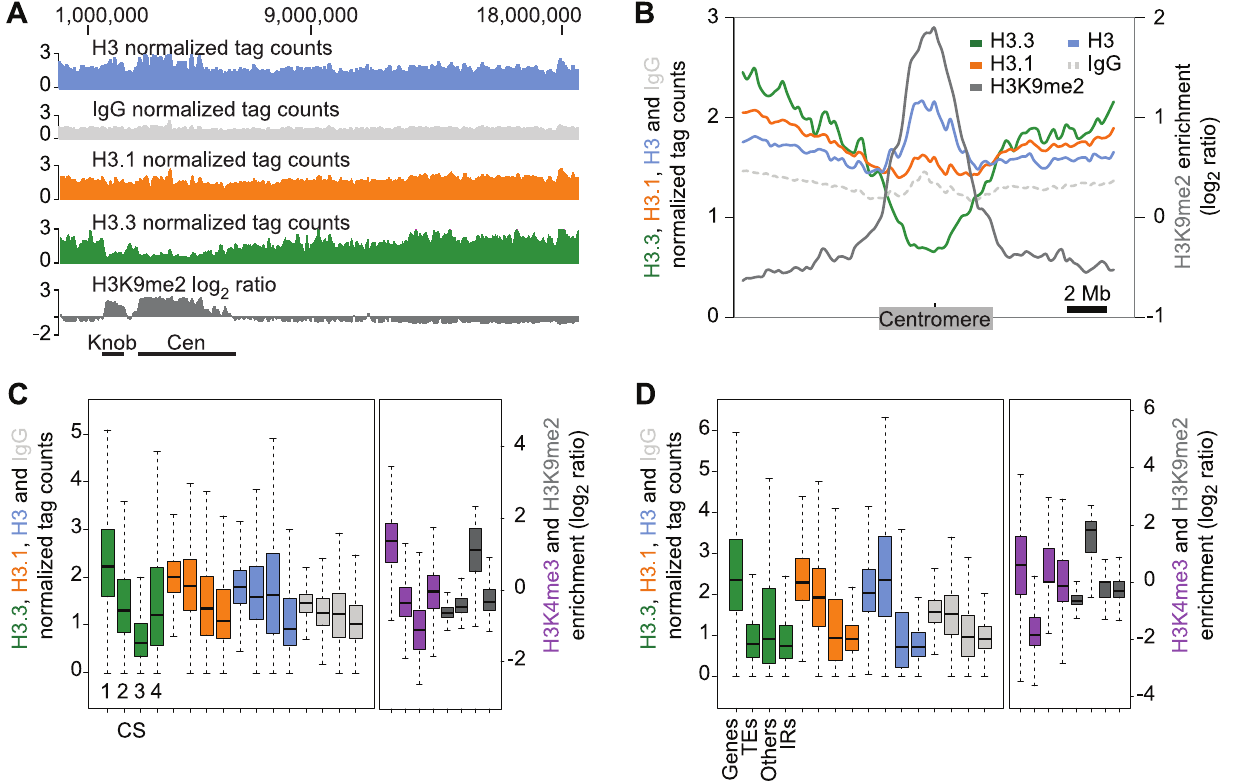
Figure 1. Genomic distribution of H3.3 and H3.1 enrichment over distinct chromatin states and genomic features. (A) Smoothed density of H3 (blue), IgG (light grey), H3.1 (orange), H3.3 (green) and H3K9me2 (dark grey), a heterochromatin mark, over the complete chromosome 4. The heterochromatic knob and centromeric regions are shown as black bars. Note the anti-correlation of H3.3 and H3K9me2 at the heterochromatic knob and over the centromere. (B) Average profile of H3.3 (green), H3.1 (orange), H3 (blue), IgG (light dashed grey) and H3K9me2 (dark grey) over 20 Mb genomic regions of the five chromosomes, centered on the middle of their centromeres. The anti-correlation between H3K9me2 and H3.3 enrichment is general over all centromeres. (C–D) Boxplot representations of the average enrichment of H3.3 (green), H3.1 (orange), H3 (blue), IgG (light grey), H3K4me3 (purple) and H3K9me2 (dark grey). (C) Distribution over chromatin states defined by [37]: 1545 CS1 regions mostly associated with H3K4me3, H3K9me3 and H3K36me3 active marks, 1046 CS2 regions associated mostly with H3K27me3 and H3K27me2 repressive marks, 637 CS3 regions associated mostly with H3K9me2, H4K20me1 and H3K27me1 constitutive heterochromatin marks, and 2413 CS4 regions with no prevalent marks. H3.3 is preferentially associated with CS1 and less with CS3 whereas H3.1 is more uniformly distributed. (D) Distribution over all genomic features annotated in TAIR9: 27337 protein-coding genes (Genes), 4838 transposable elements and pseudogenes (TEs), 1392 other annotations (Others), and 32910 inter-annotation regions . 150 bp (IRs). H3.3 enrichment is much lower than H3.1 over TEs, and both H3 variants are more associated with genes than with inter-annotation regions.